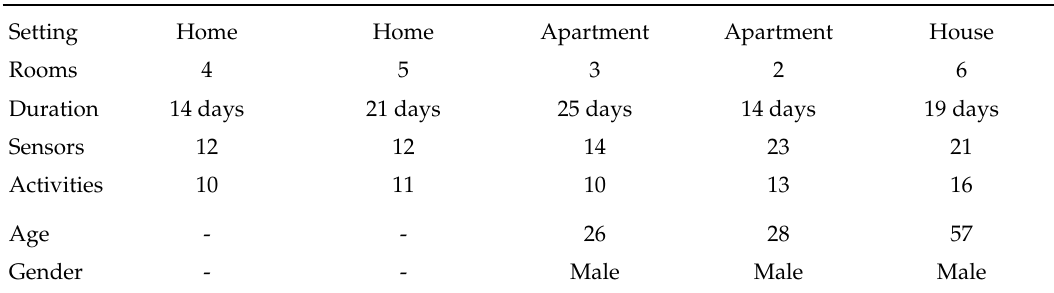
Table 1. Details of the datasets.